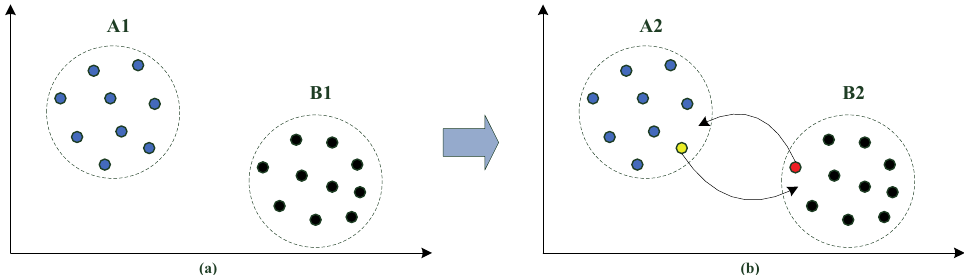
Fig.1. Analysis of cluster internal